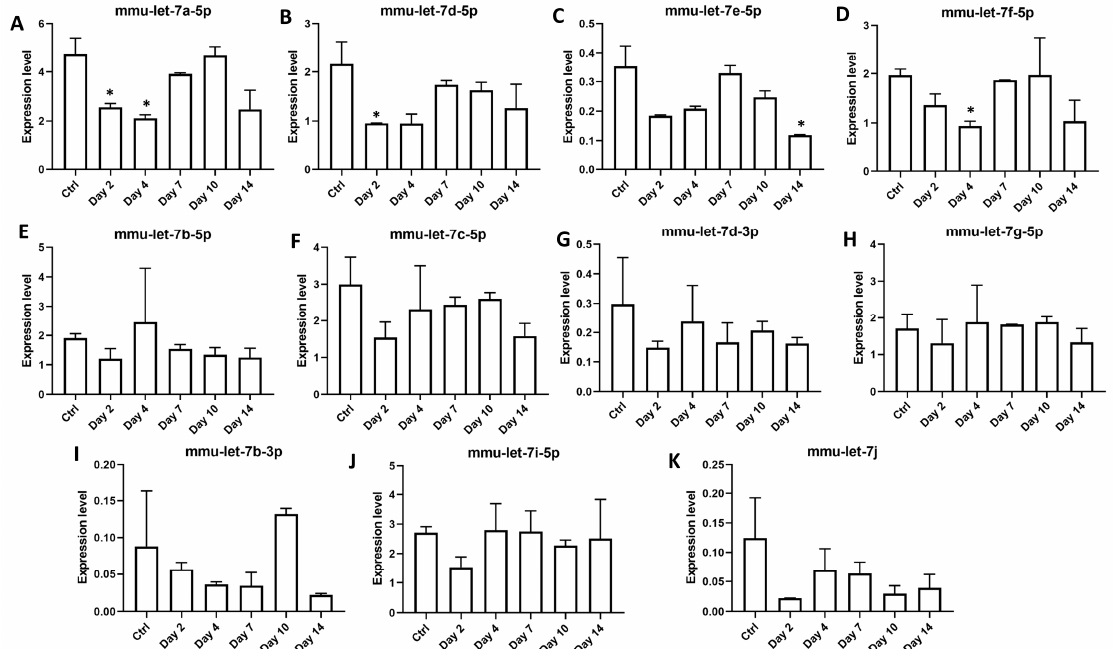
Figure 4. Members of let-7 family of microRNAs are dynamically regulated during infection. Expression levels of eleven members of the let-7 family (panel A – K , normalized to the average expression of mmu-miR-27a-3p and mmu-miR-30d-5p) in exosomes isolated from serum of control or infected mice (2, 4, 7, 10, 14 days post infection). Exosomes were isolated from two pools of sera for each time point. Error bar, standard deviation from two pooled biological replicates. The experiment was repeated twice and representative data were shown. * p -value ≤ 0.05 comparing with the controls.